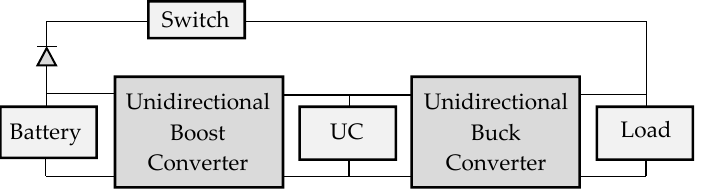
Figure 1. Active Hybrid Energy Storage System (HESS) topology used in this study.